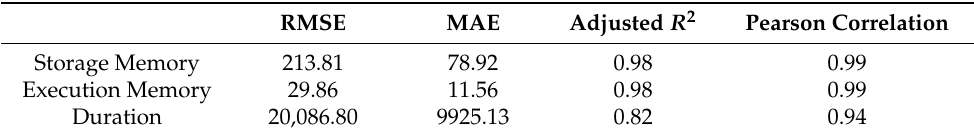
Table 11. Performance evaluation of the prediction model.